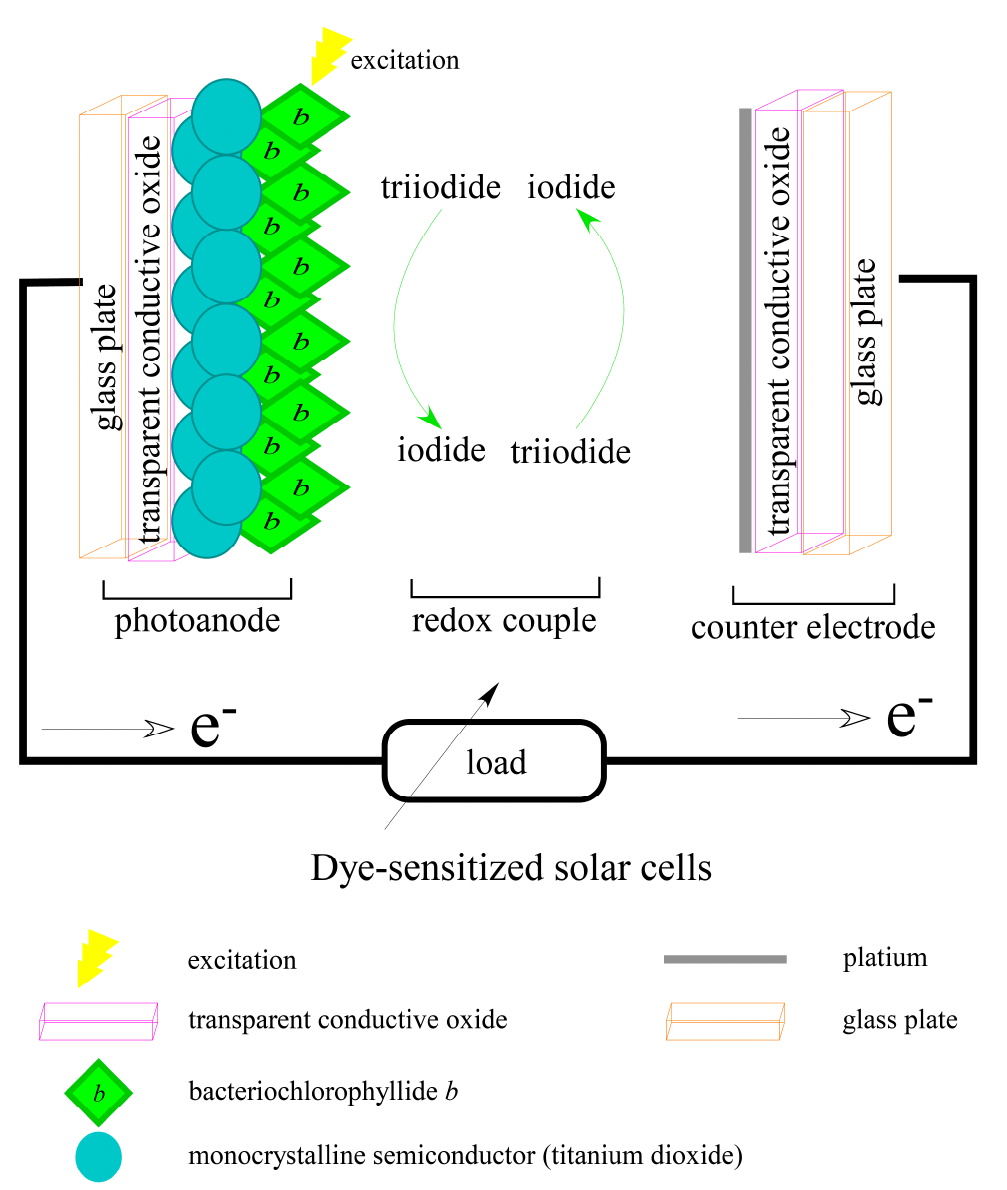
Figure 6. Schematic drawing of bacteriochlorophyllides used as a component of dye-sensitized solar cells (Modified from Shalini et al. [70]).